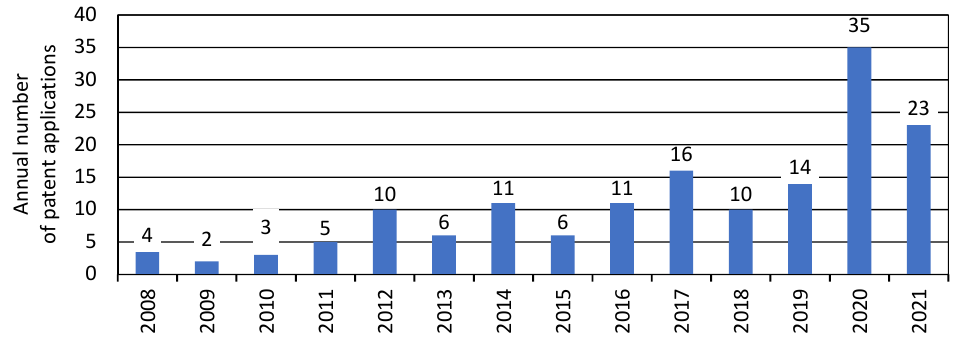
Figure 3. Annual number of patent applications according to publication year. Data for 2021 is incomplete, not all patent documents from this year are indexed in databases. The data on the annual number of patents presented in Figure 3 show a significant increase in patent applications in the last two years.